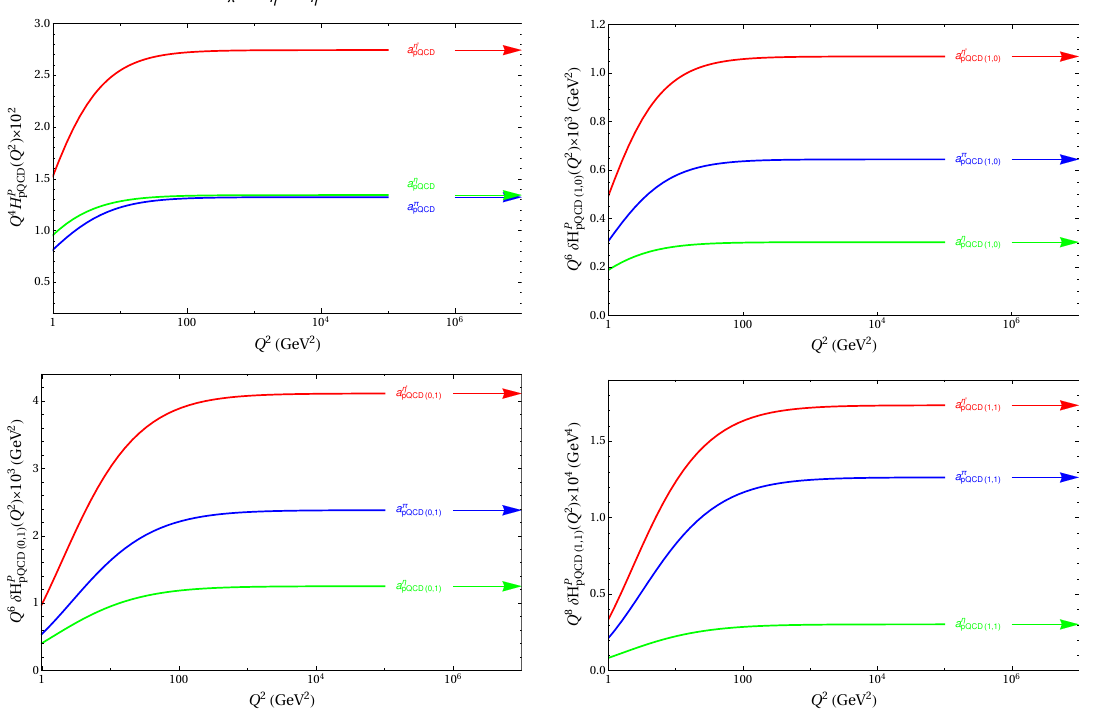
Figure 21. Numerical checks for the validity of commuting the expansion in Q 2 and the integration over y in (C.30). In all cases, we can see that the curves tend to the coe(cid:14)cients obtained by expanding in the virtualities (cid:12)rst and then integrating over the Feynman parameter y . Note that the scales on the y -axis vary between the